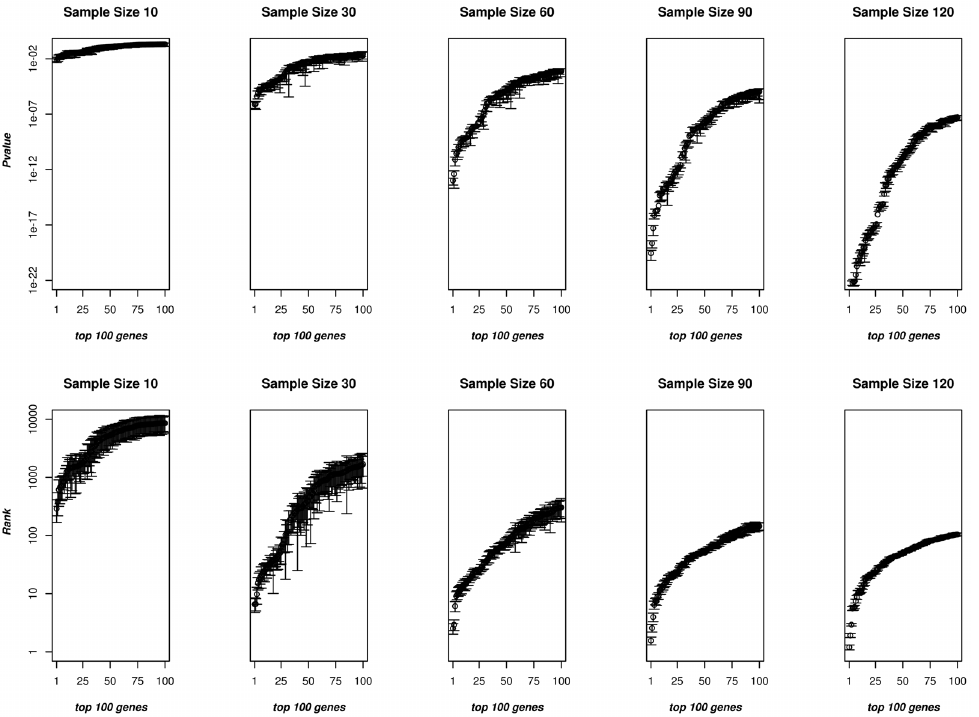
Figure 1. The effect of sample size on p-values and rank order for the top 100 transcripts. For each n tested (n=10 (5 R , 5 = ), 30 (15 R , 15 = ), 60 (30 R , 30 = ), 90 (45 R , 45 = ) and 120 (60 R , 60 = ) are shown here), n samples were randomly selected from our dataset of n=134 subjects, 50 different times. Top panels: The average and 95% confidence intervals of the p-values for the top 100 transcripts. As sample size was increased, the average p- value decreased and became less variable. Bottom panels: The average and 95% confidence intervals rank for the top 100 transcripts. As sample size was increased, the average rank decreased and became less variable.